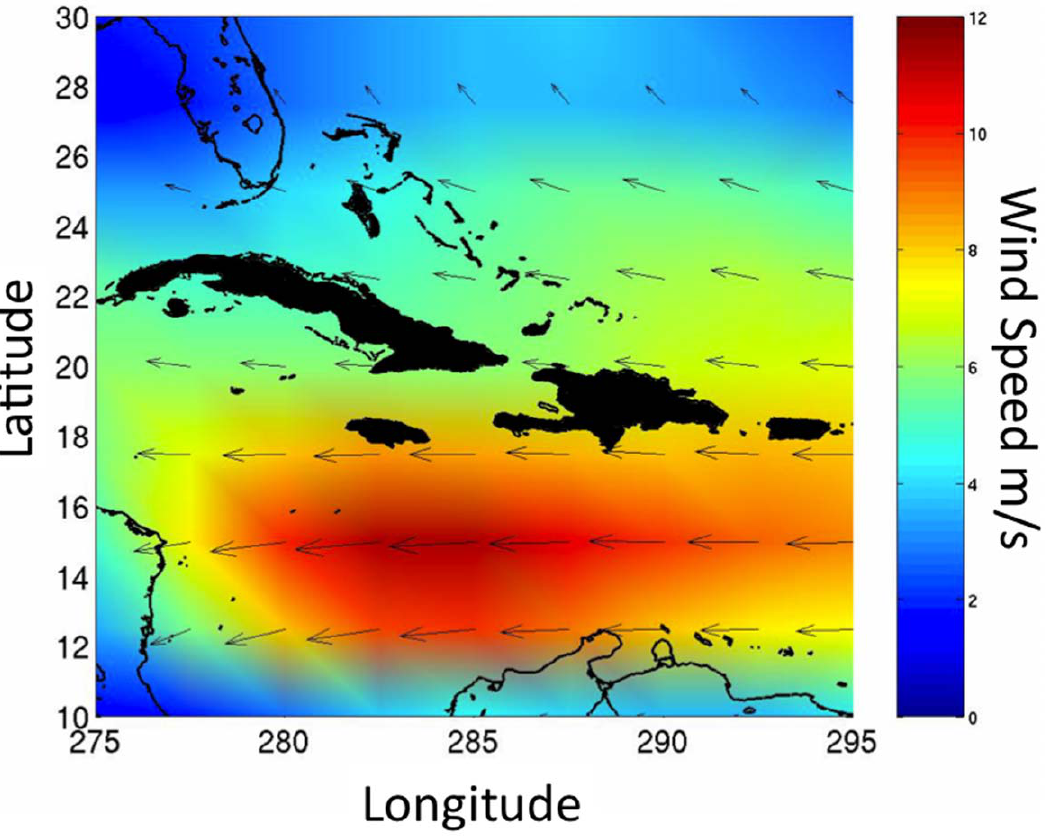
Figure 2. Wind surface of study area. A graphical representation of mean surface winds in the study area, as an example, during the month of June from 1948 to 2006. Right-hand scale shows wind magnitude in m/s.